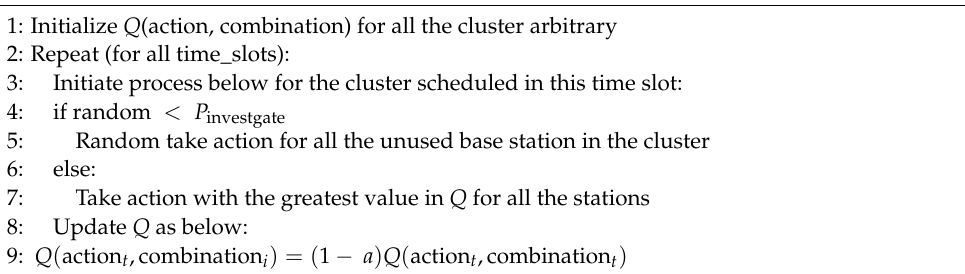
Algorithm 5 Collaborative multipoint transmission collaborative algorithm